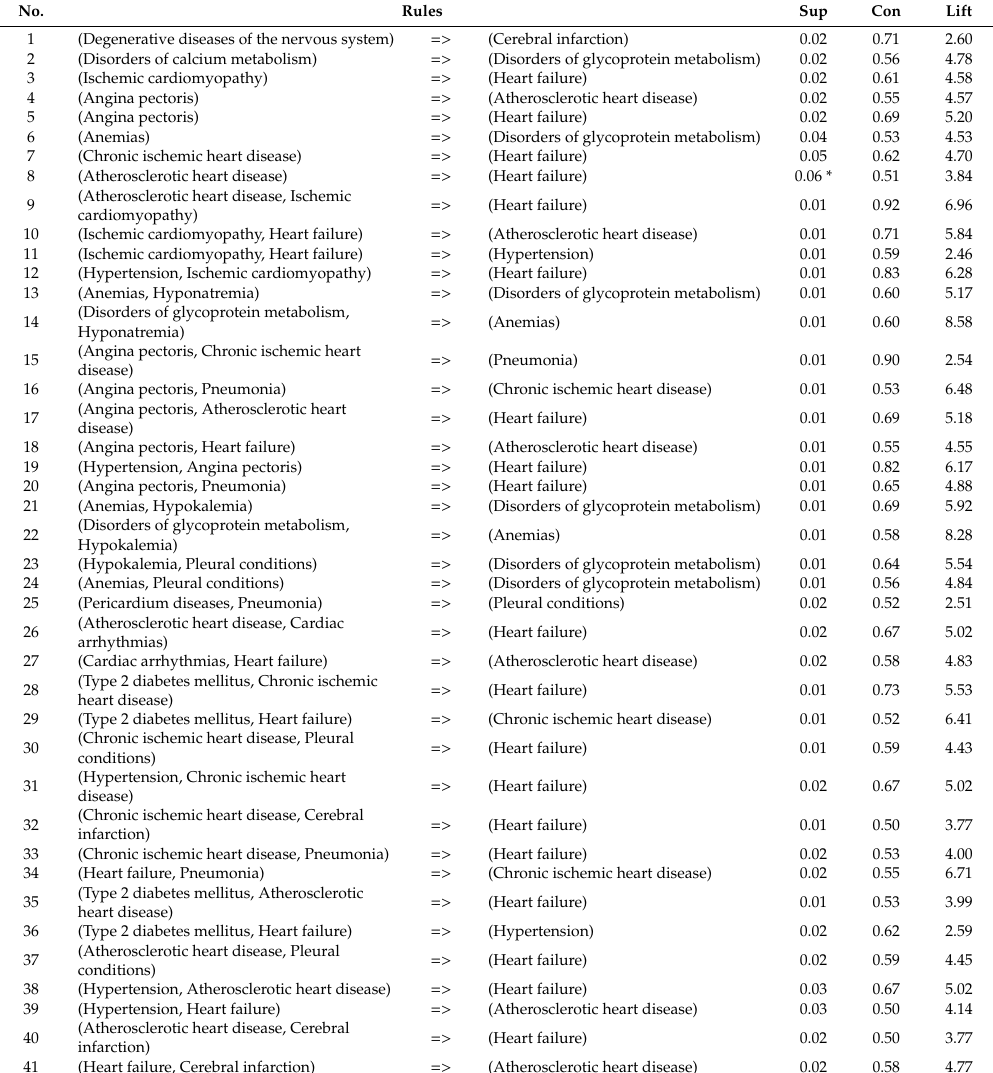
Table 3. The association rules detected among lung cancer